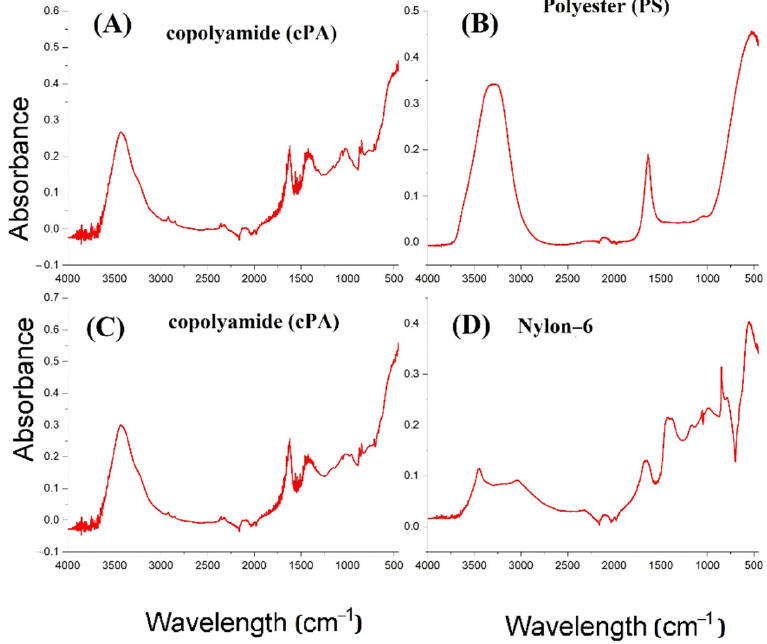
Figure 5. FTIR spectra of cPA ( A , C ), PS ( B ), and nylon 6 ( D ) present in samples.